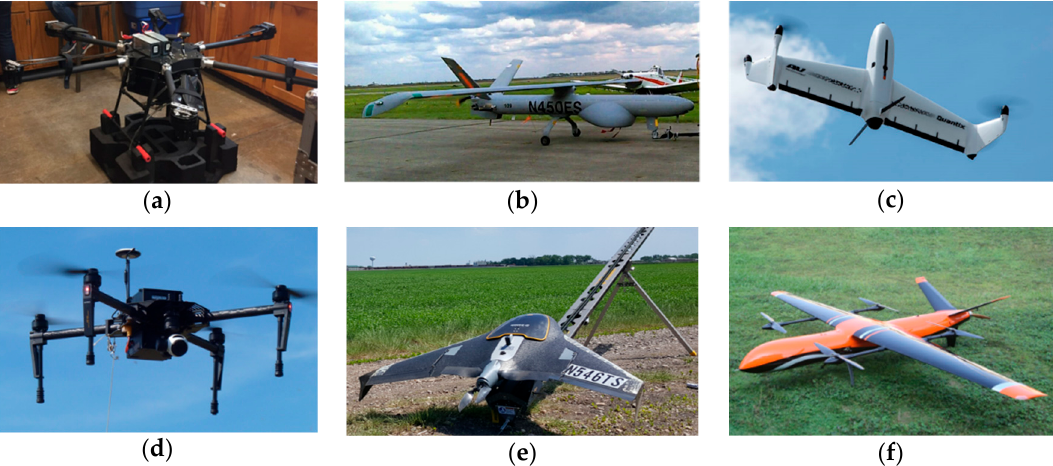
Figure 1. UAVs’ types that are used in precision agriculture; ( a ) six rotary-winged, ( b ) large fixed-winged, ( c ) VTOL (Ver- tical Take-Off and Landing), ( d ) four rotary-winged, ( e ) mini fixed-winged, and ( f ) large